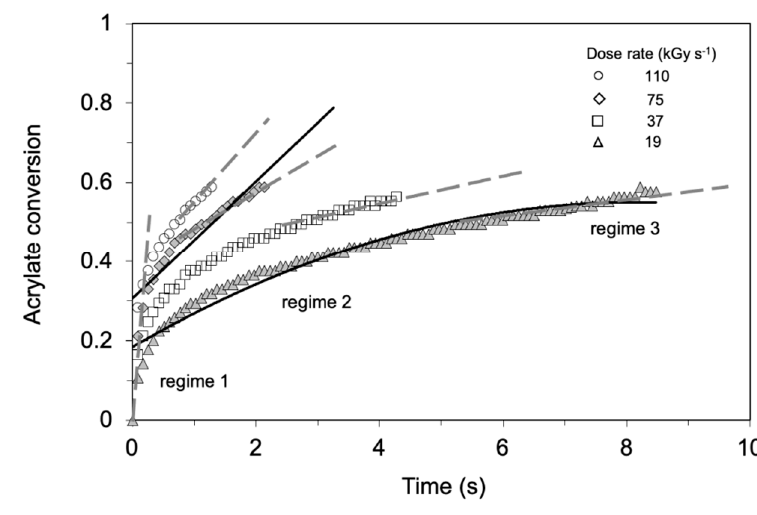
Figure 4. Kinetic profiles of acrylate consumption for EPAC prepolymer processed at different dose rates.